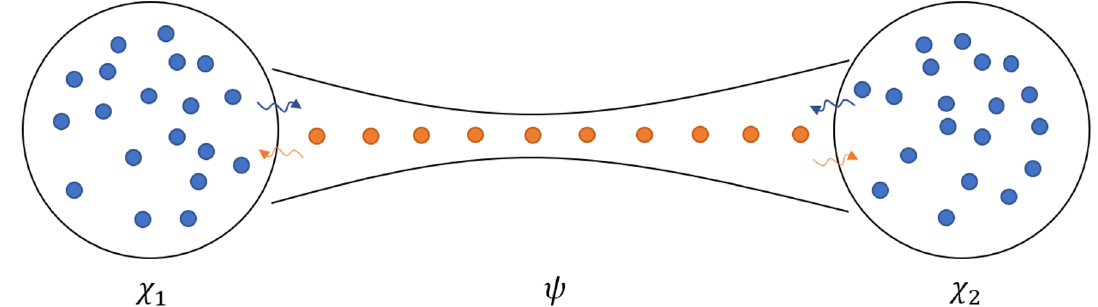
Figure 12 . The combined system, where the SYK subsystems are connected by the Majorana